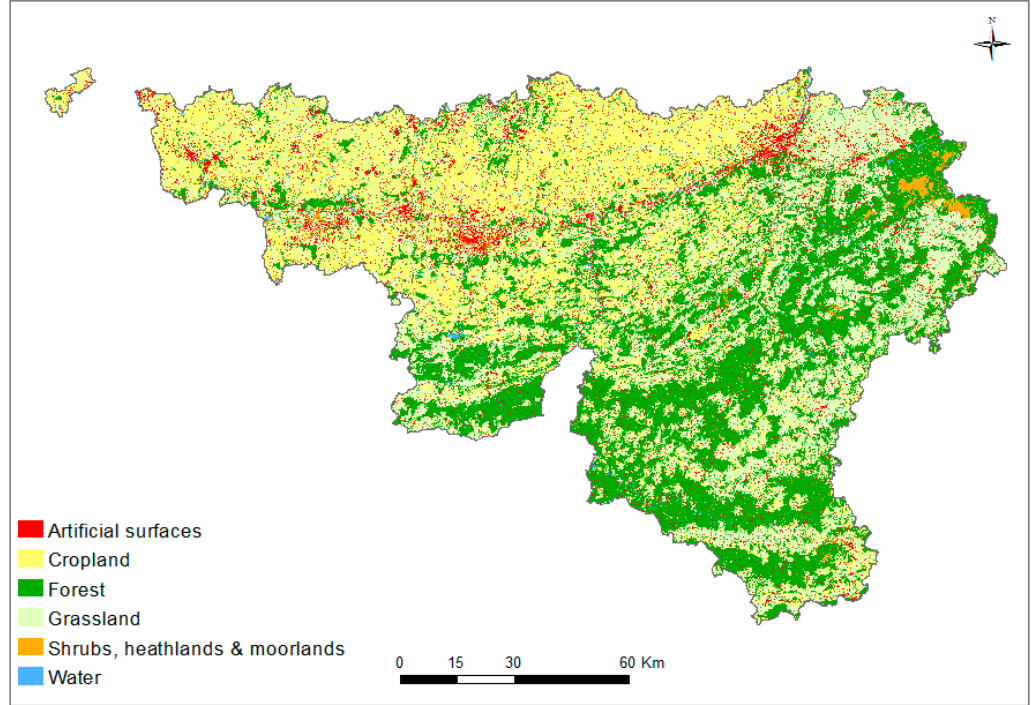
Figure 2. Land use and land cover (LULC) in Wallonia.